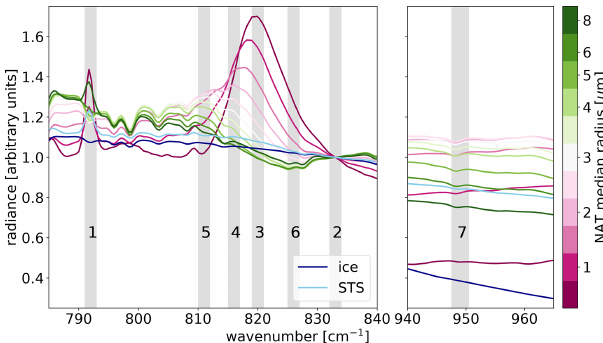
Figure 1. Selected simulation results for infrared spectra in the pres- ence of polar stratospheric clouds consisting of NAT particles with different particle median radii, STS, and ice. The spectra have been scaled using the mean radiance in the 832.0–834.0cm − 1 (MW2) spectral window such that the radiance for all spectra equals one in this window. The grey vertical bars mark the micro-windows (MWs) used during the analysis; they are numbered from MW1 to